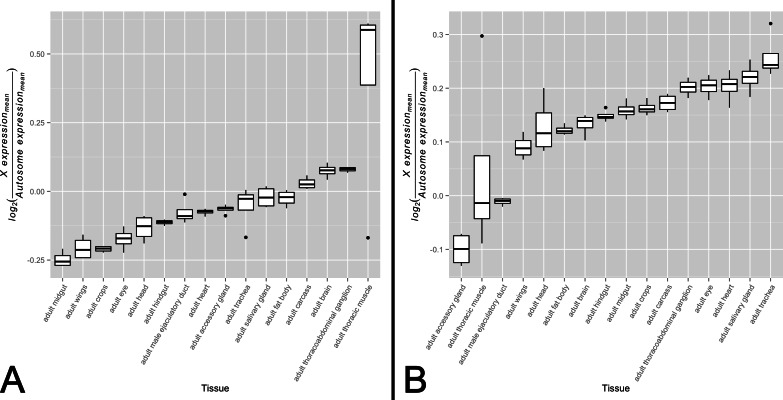
X-to-autosome expression variation among somatic tissues.X-to-autosome expression estimates were calculated for all four FlyAtlas replicates for each tissue using the log2 transformed ratios of the mean expression of X-linked expressed genes to mean expression of autosomal expressed genes for both the (A) non-sex-biased gene set and (B) sex-biased gene set. Tissues are sorted by their median log2 ratio among the FlyAtlas replicates.